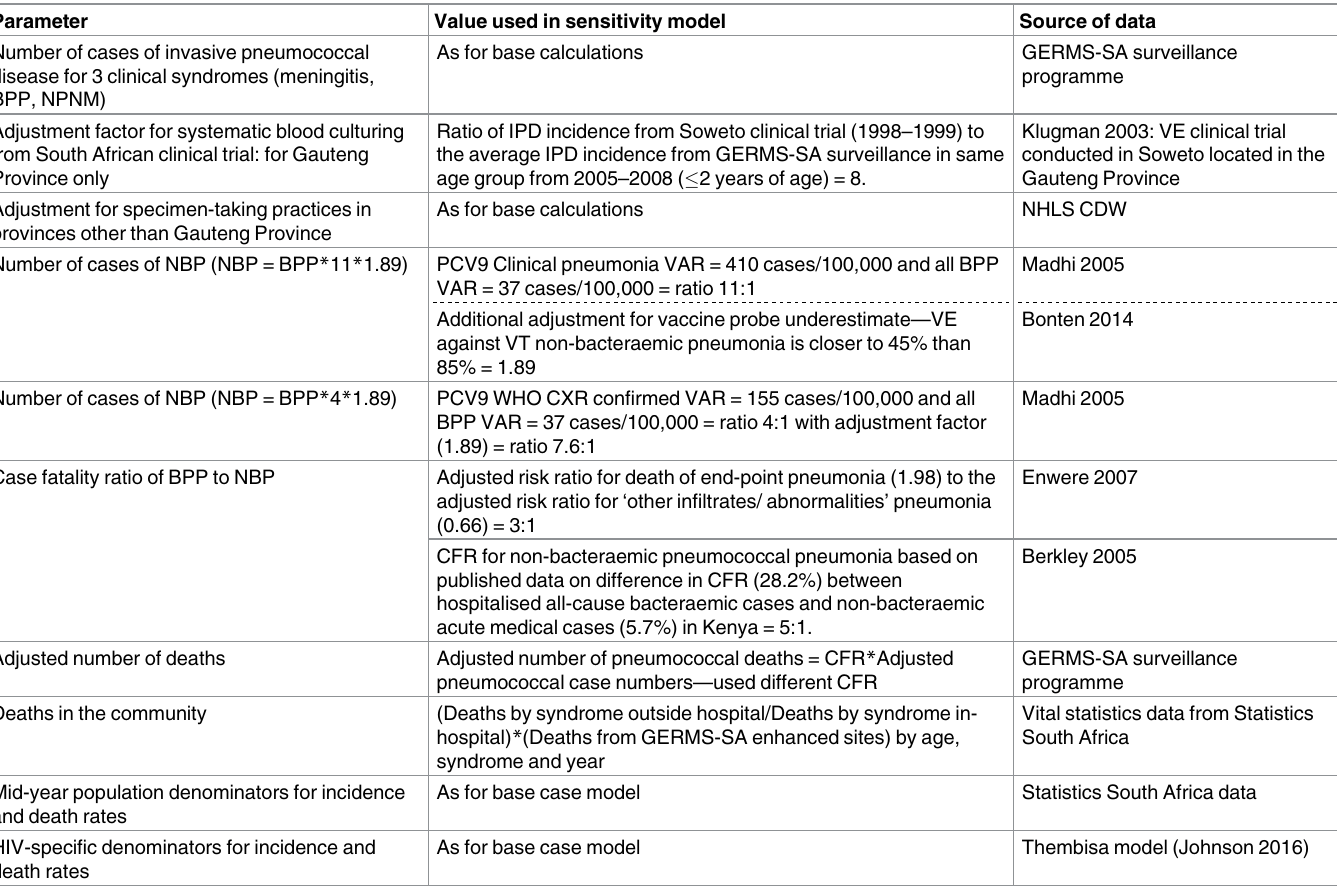
Table 2. Parameters for sensitivity analysis for severepneumococcal disease among children aged < 5 yearsin South Africa. Parameter Value used in sensitivity model Source of data Number of cases of invasive pneumococcal As for base calculations disease for 3 clinical syndromes (meningitis, BPP, NPNM) Adjustment factor for systematic blood culturing Ratio of IPD incidence from Soweto clinical trial (1998–1999) to from South African clinical trial: for Gauteng the average IPD incidence from GERMS-SA surveillancein same Province only age group from 2005–2008 ( (cid:20) 2 years of age) = 8. Adjustment for specimen-taking practices in provinces other than Gauteng